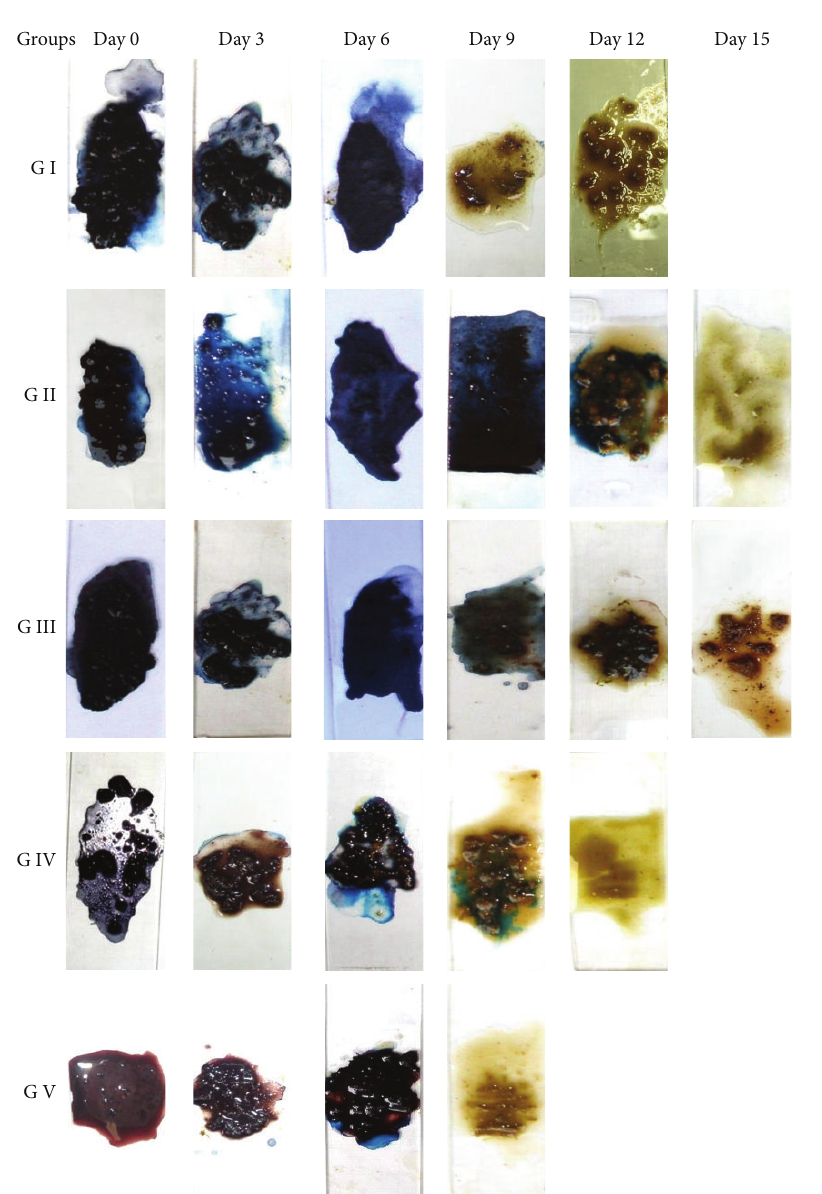
Figure 3: Representative fecal occult blood test reactions of dogs in different groups at various observation